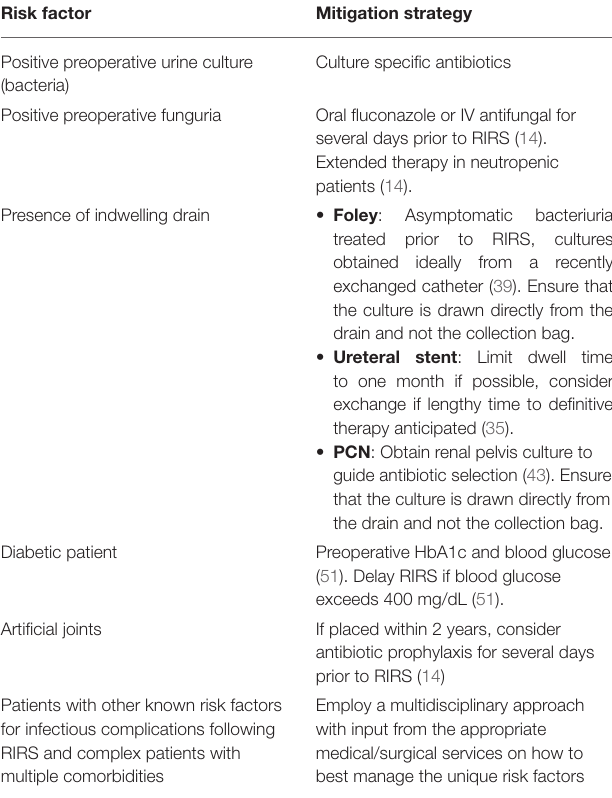
TABLE 1 | Summary of pre-operative